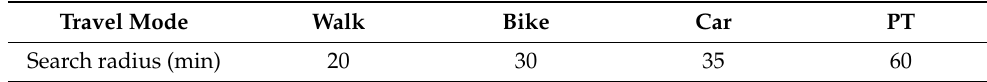
Table 3. The maximum acceptable travel time under four travel